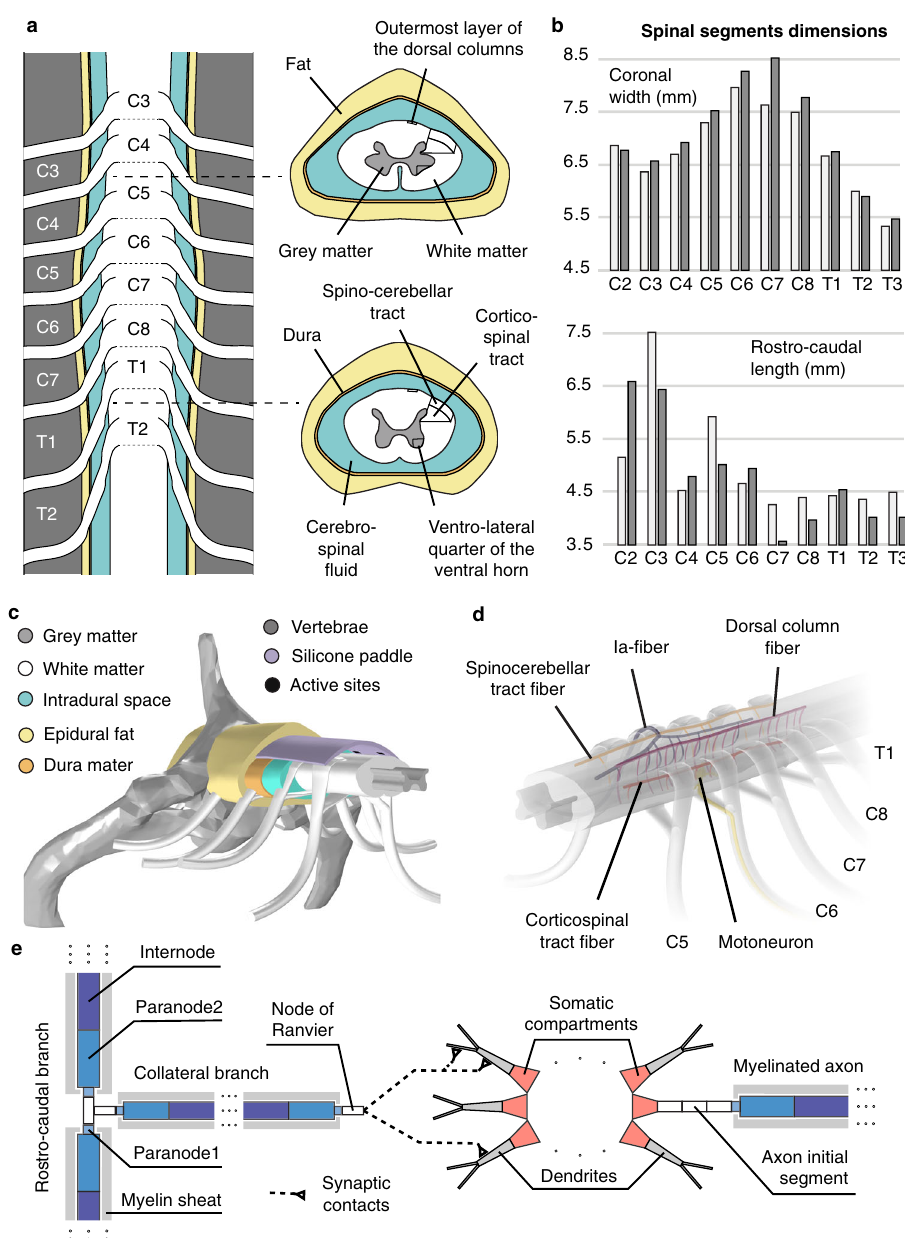
Fig. 1 Morphology and computational model of the monkey cervical spinal cord. a Macroscopic organization of the cervical spinal cord. Left: relationships between spinal segments, spinal roots, and vertebrae. Right: cross-sections at the C5 and T1 segmental levels showing the internal compartmentalization of the spinal cord. b Spinal segments dimensions. The two shades of gray indicate measurements coming from two different spinal cord dissections. c Tridimensional view of the volume conductor. d Trajectories of virtual nerve fi bers and motoneurons. e Compartmentalization of myelinated nerve fi bers and motoneurons used in neurophysical simulations 32,37,39